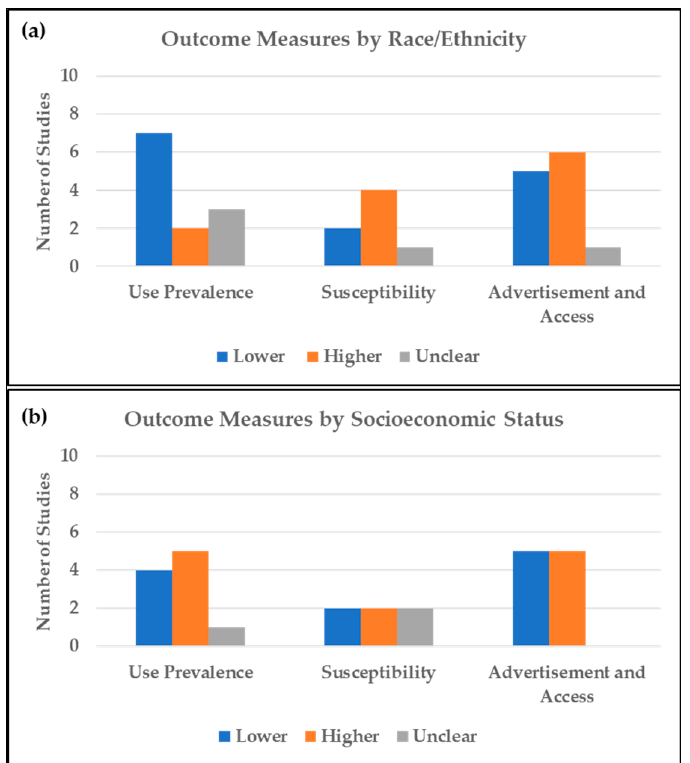
Figure 2. Distribution of studies showing the direction of potential environmental tobacco exposure (ETE) from ENDS among ( a ) racial/ethnic minorities compared to non-Hispanic whites, and ( b ) low socioeconomic status compared to high socioeconomic status. Higher: refers to higher potential for ETE among minorities and low SES groups. Lower: refers to lower potential for ETE among minorities and low SES groups. Unclear: contradictory or complex patterns of potential ETE.